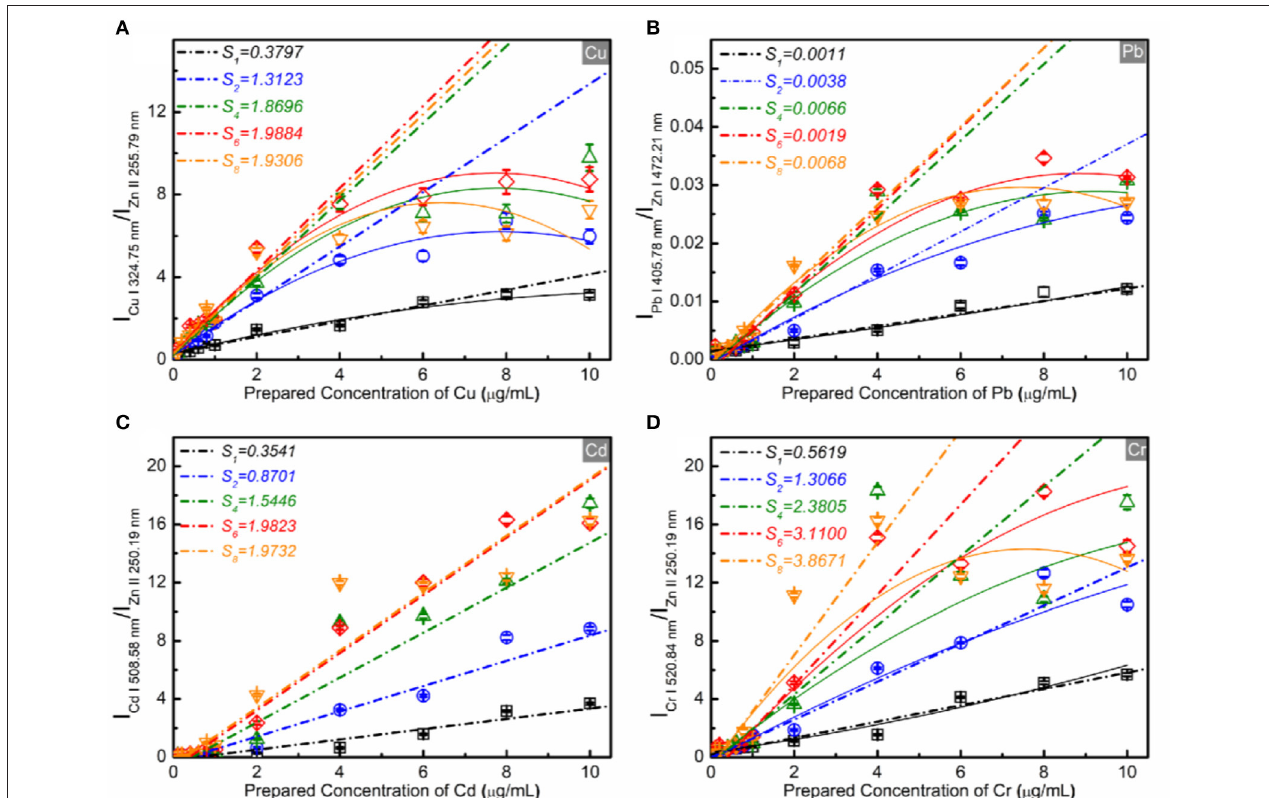
FIGURE 5 | Calibration curves with linear fit (short dash dots line) and a quadratic fit (solid line) of trace elements [Cu (A) , Pb (B) , Cd (C) , and Cr (D) ] in the standard samples analyzed by SENLIBS with different number of repeating sample preparations.